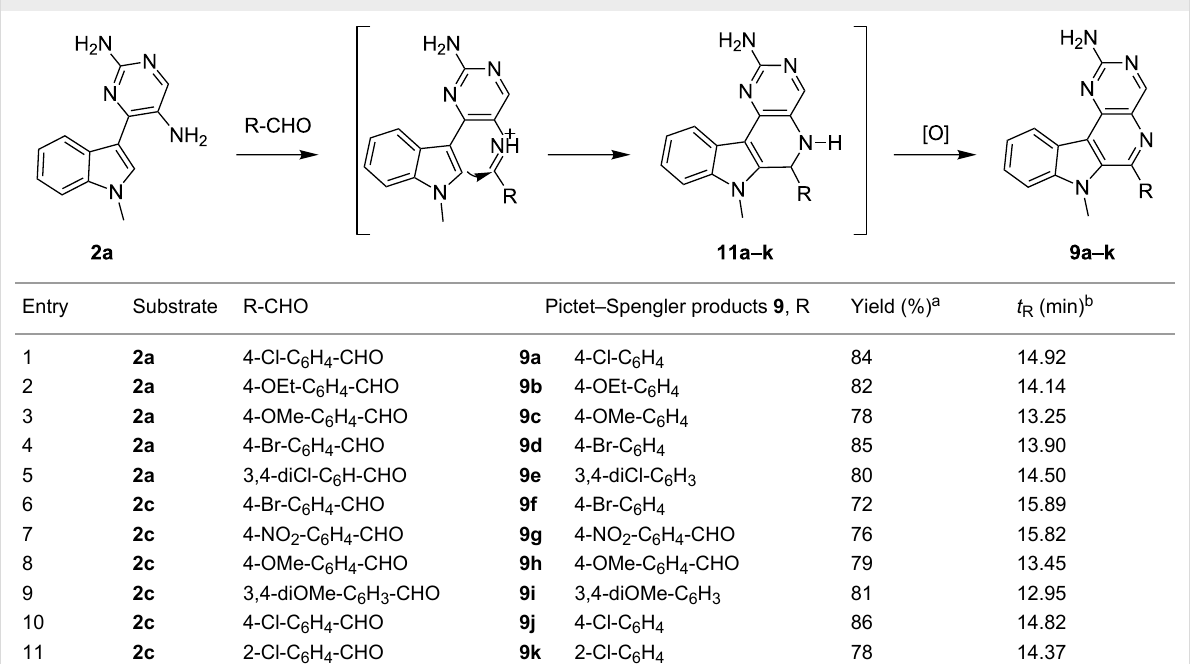
Table 2: Pyrimido- β -carbolines based on 9 .